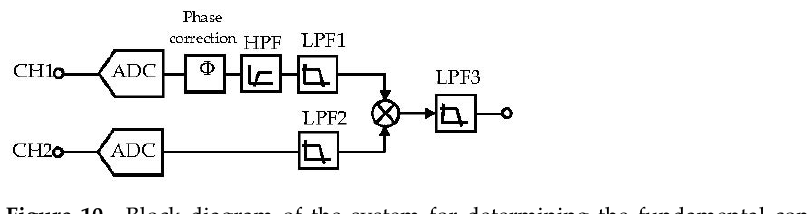
Figure 10. Block diagram of the system for determining the fundamental component of the active power.